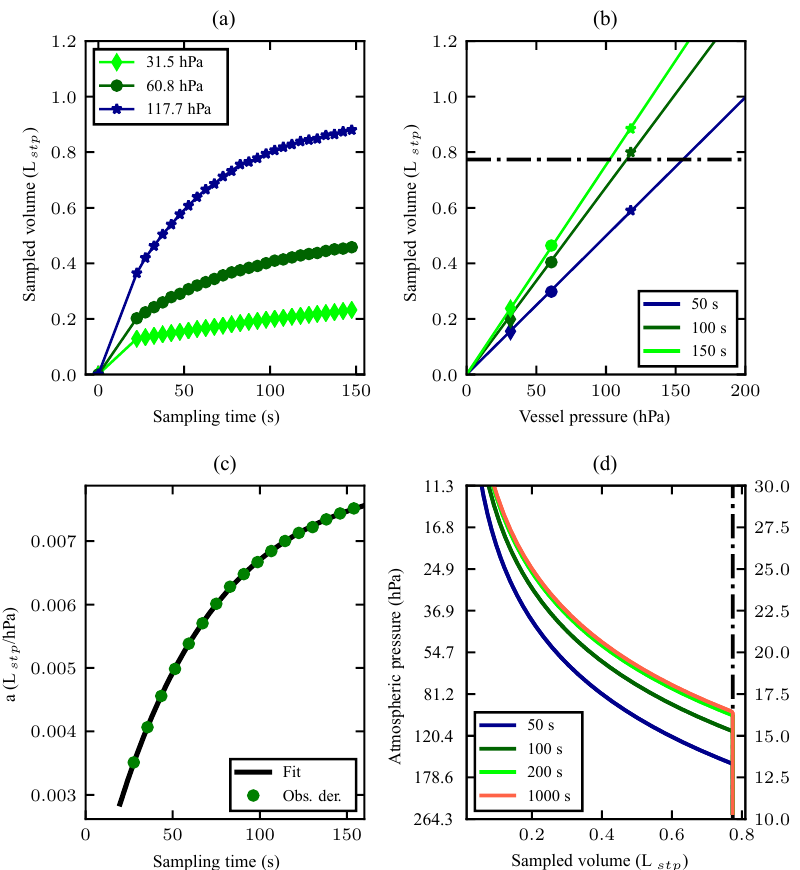
Figure 3. (a) Sample volume as a function of the sampling time in seconds. The first 19 . 7s fill the bag up to the pressure in the vessel. The sampled volume in the first 19.7s linearly interpolated starting at zero, e.g. assuming that sampled volume increases linearly with time.